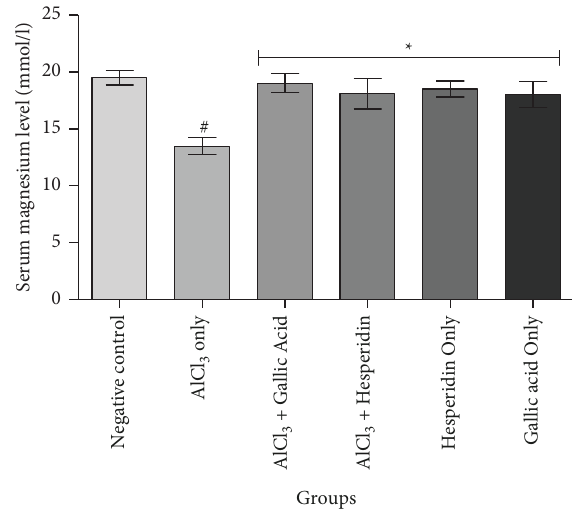
Figure 7: Effect of gallic acid and hesperidin on the serum magnesium level in AlCl 3 -induced nephrotoxicity in Wistar rats. Values are expressed as the mean ± standard deviation of six de- terminations. # p < 0 . 05 vs negative control, ∗ p < 0 . 05 vs. AlCl 3 only.